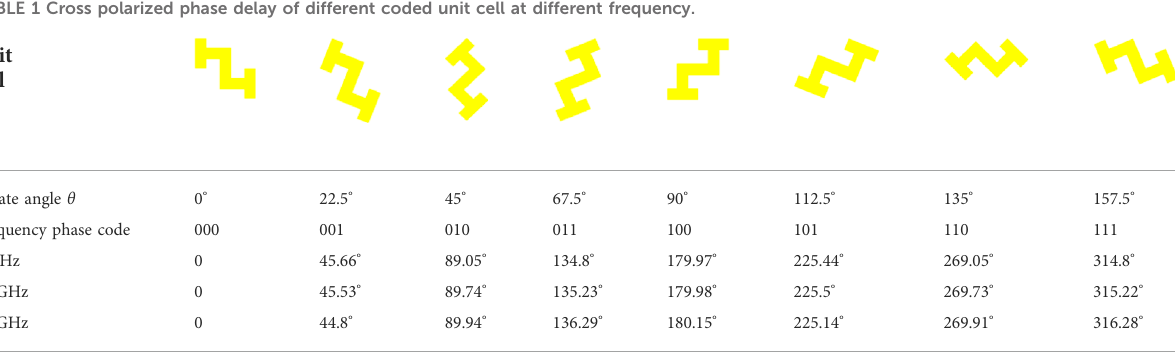
TABLE 1 Cross polarized phase delay of different coded unit cell at different frequency. unit cell